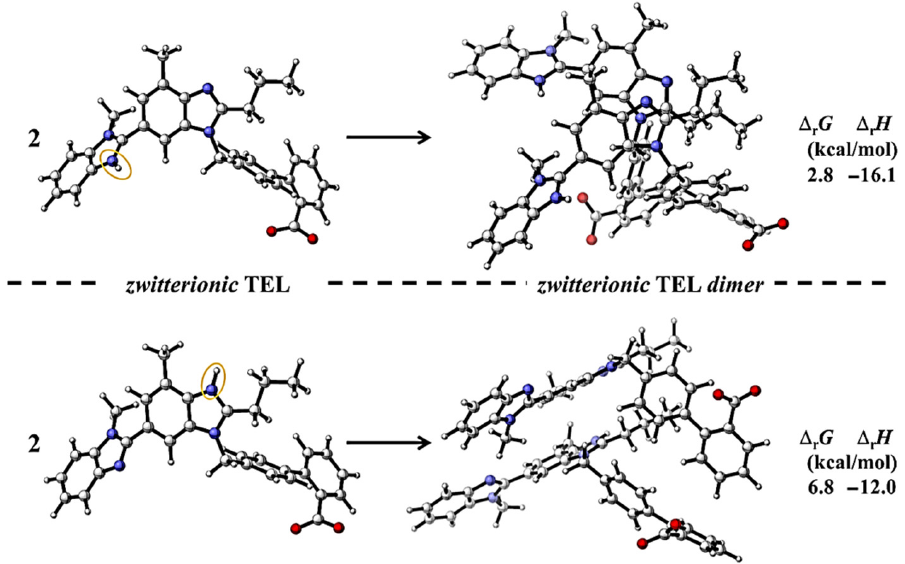
Figure 7. Dimerization of zwitterionic telmisartan along with the corresponding reaction Gibbs free energy ( ∆ r G ) and enthalpy ( ∆ r H ) values in kcal/mol. The structures have been computed at the M06-2X/6-31G(d) level of theory. The effect of water was mimicked by using the CPCM implicit solvent model. Orange ellipsoids indicate the protonation sites.